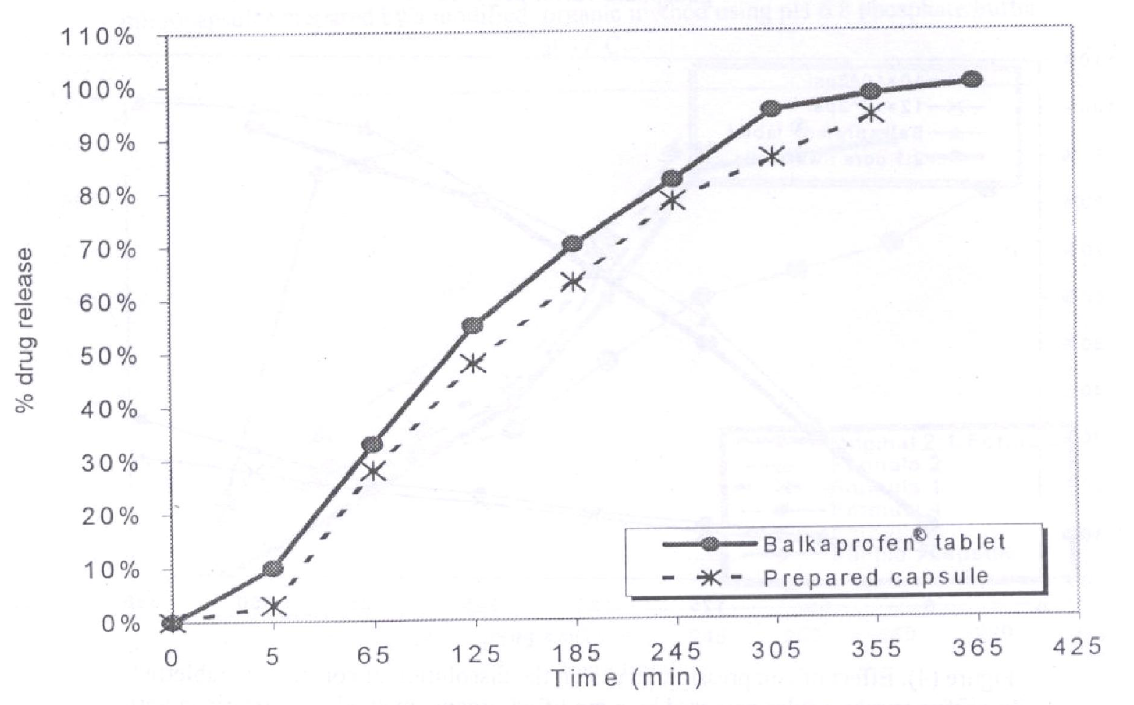
Figure (6): Comparison of dissolution of encapsulated 2:1 core:wall ratio ibuprofen microcapsules with Balkaprofen ® tablet using pH 6.8 phosphate buffer at